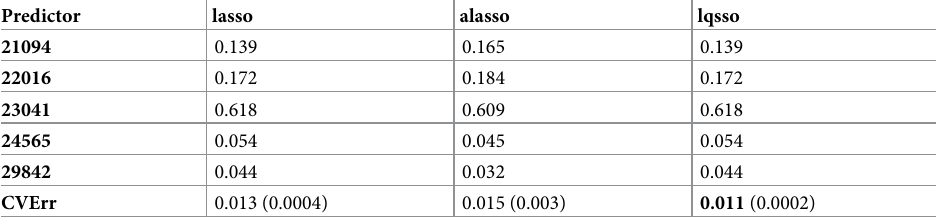
The estimated mean values for cross-validation test error, their standard errors (in bracket) and the coefficients using lasso, adaptive lasso (alasso) and lqsso methods along with the model selection criteria in analyzing the rat eye